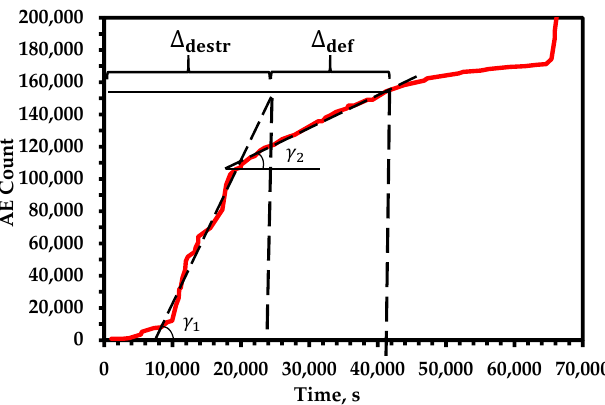
Figure 3. The destructive and deformational components of the tensile strength of nickel alloy 625.